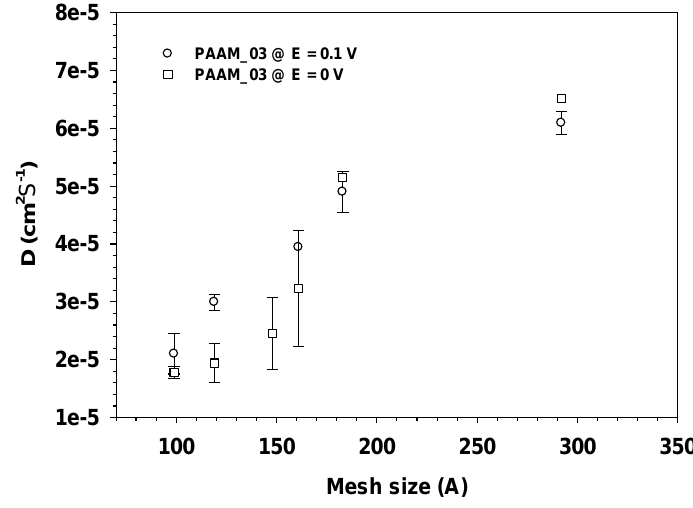
Figure 9. The diffusion coefficient, D 0.1 V) vs. Mesh size at pH = 5.5, and at 37